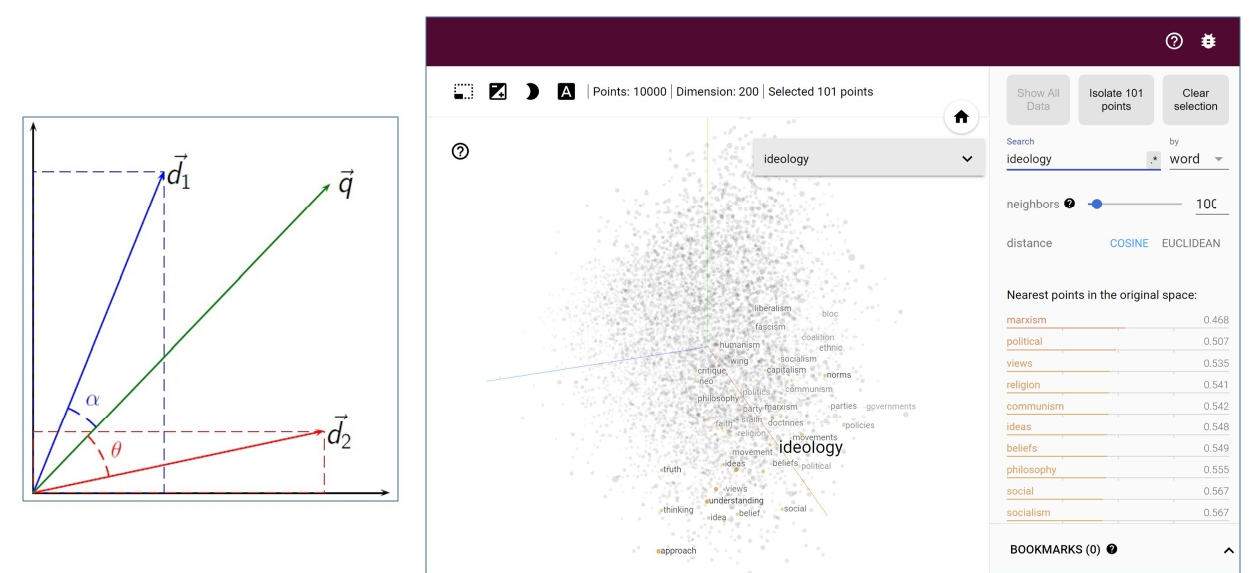
Figure 6. Left : cosine similarity function geometrically represented. Right : cosine similarity in word vector space showing closest words to “ideology”. Available on: https://projector.tensorflow.org/ (accessed on 28 July 2022) (screenshot).